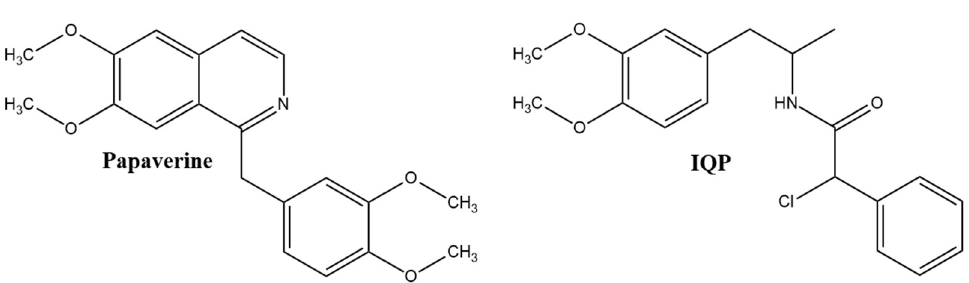
Figure 2. Chemical structures of papaverine and IQP.